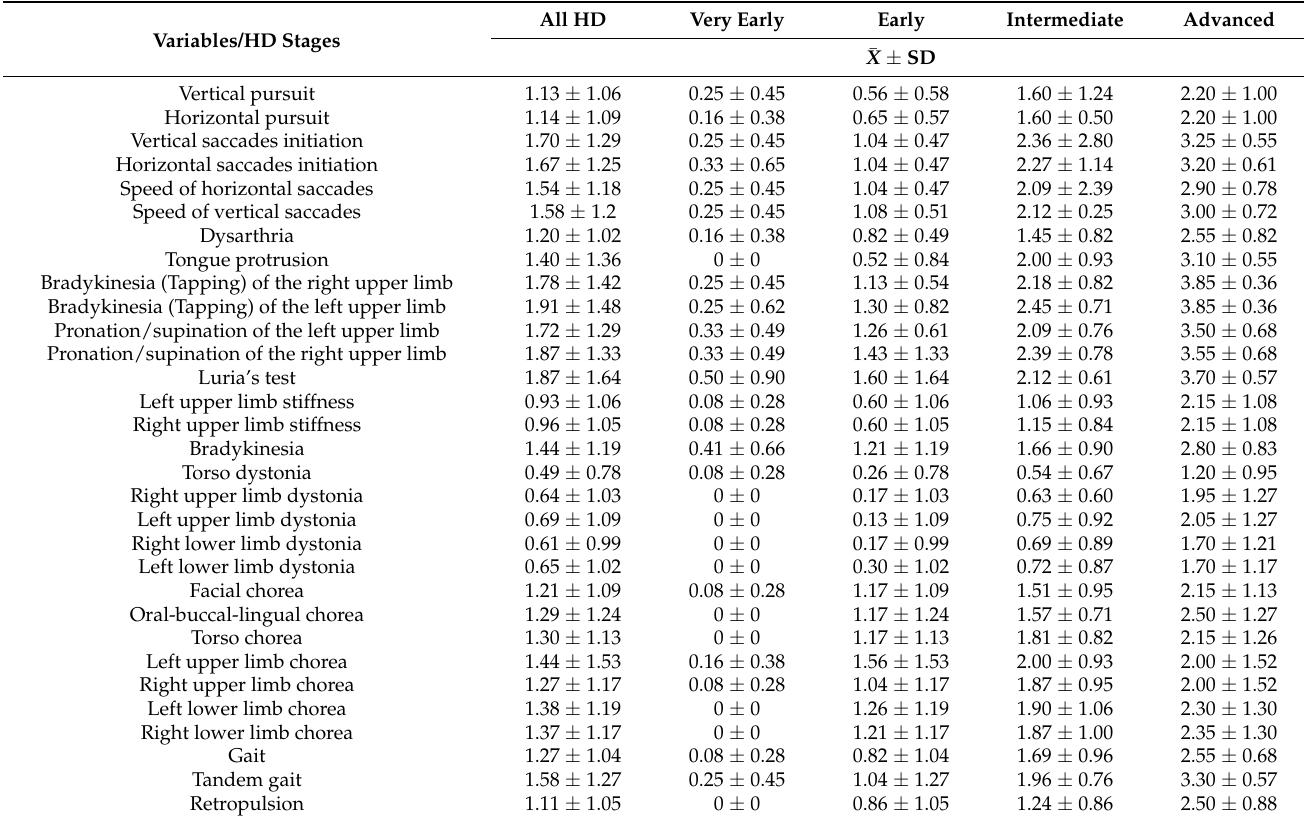
Table 2. The results of the motor UHDRS assessment in HD